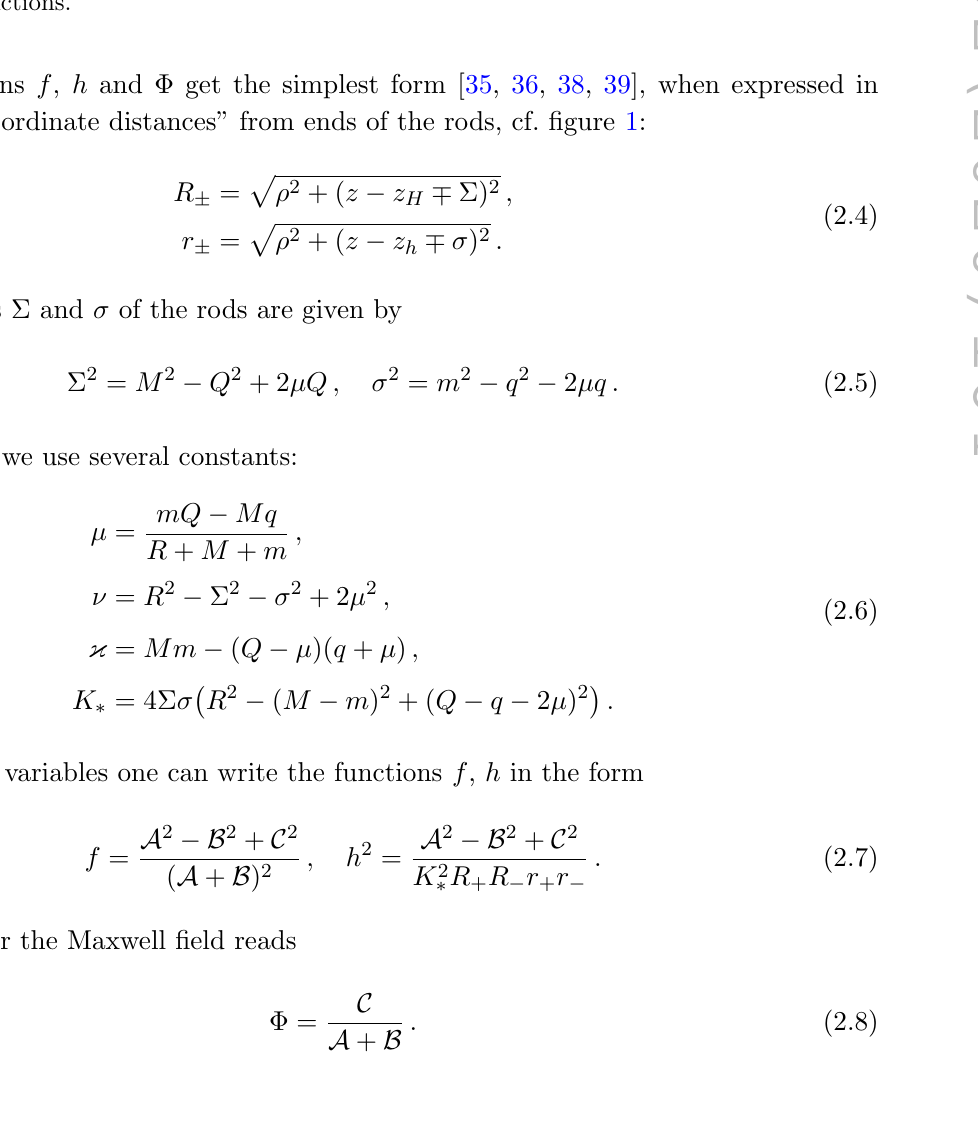
Figure 1 . The horizons of black holes in Weyl coordinates (cid:26) , z , ( t = const, ’ = const) are depicted as coordinate-singular rods placed on the symmetry axis (cid:26) = 0. The centers of these rods correspond to the coordinates z h and z H , the half-lengths of the rods are (cid:27) and (cid:6). The quantities r (cid:6) and R (cid:6) are evaluated as the coordinate distance from the ends of the rods. They play a role in expressions for the metric